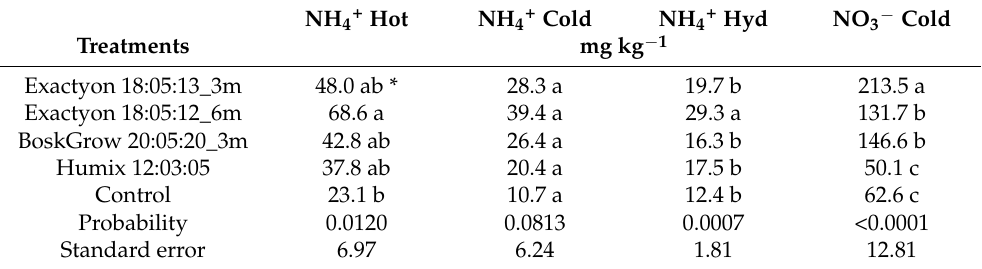
Table 5. Soil ammonium (NH 4+ ) extracted using hot and cold potassium chloride, hydrolyzable NH 4+ (Hyd) (NH 4+ hot − NH 4+ cold) and nitrate extracted using cold KCl determined from composite soil samples (n = 4) taken at 0–0.20 m in October 2021 in the plots of the different fertilization